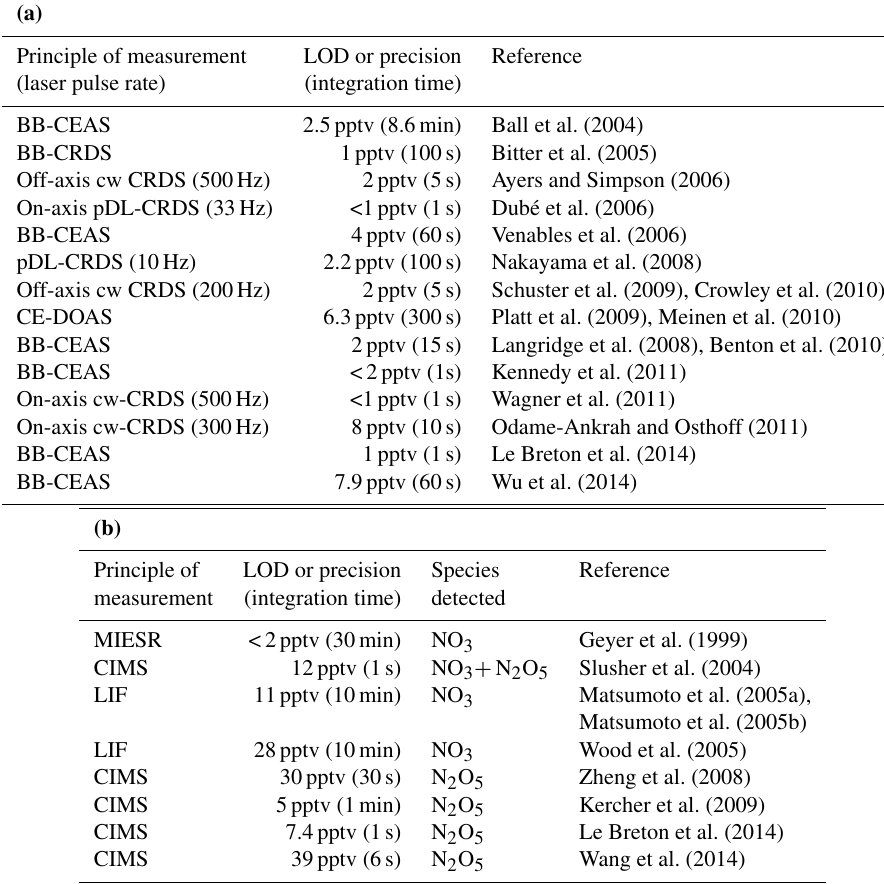
Table 3. (a) Selected CRDS and CEAS instruments used to quantify NO 3 mixing ratios in ambient air. (b) Selected instruments used to quantify NO 3 and N 2 O 5 mixing ratios in ambient air other than by cavity-enhanced absorption